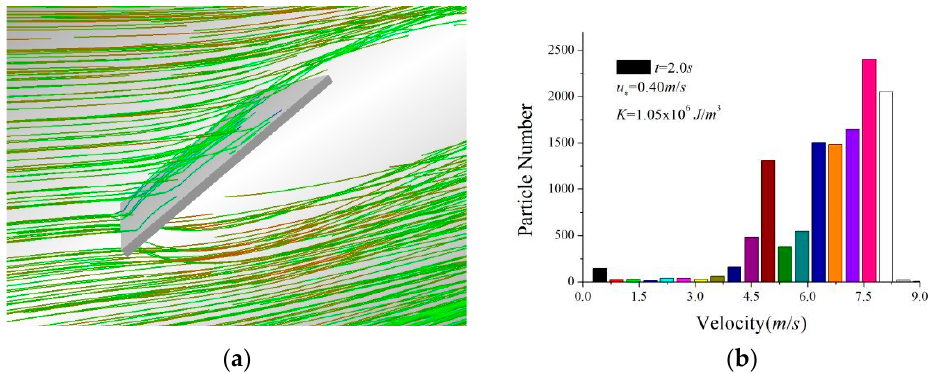
Figure 10. Movement of dust particles with a particle size of 100 µ m around solar panels when u ∗ = 0.40 m/s and K = 0.5 × 10 6 Jm − 3 . ( a ) Particle streamlines. ( b ) Velocity distribution of particles at 2.0 s.